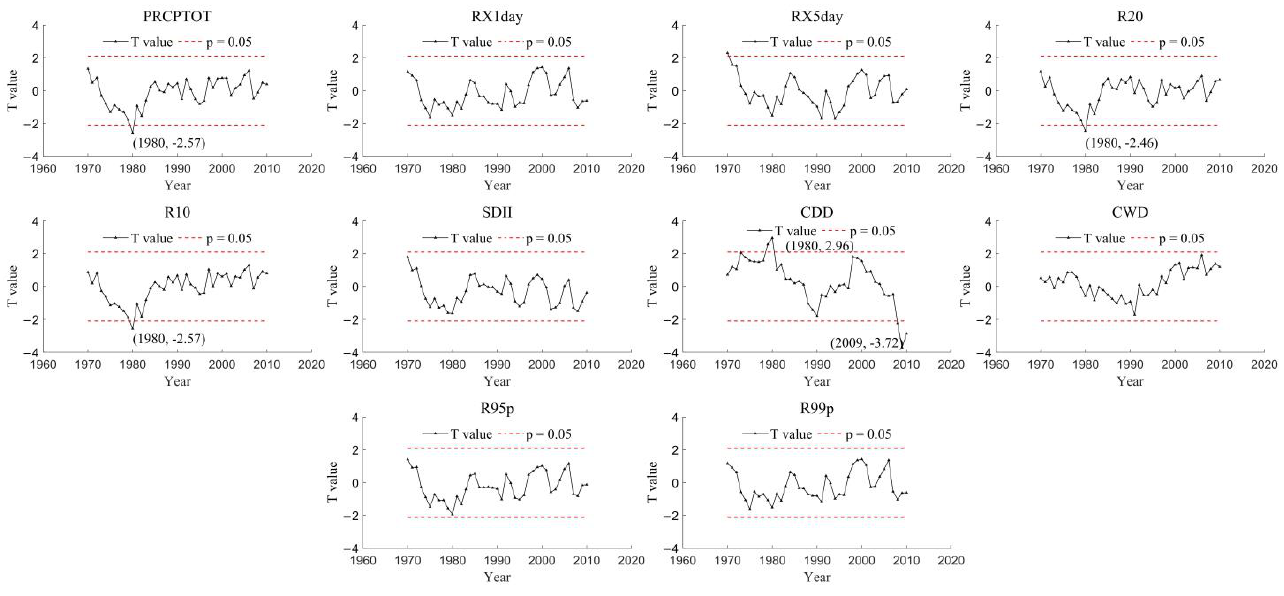
Figure 8. Moving T-test for each EPI within Hubei province in summer during 1960 – 2019.